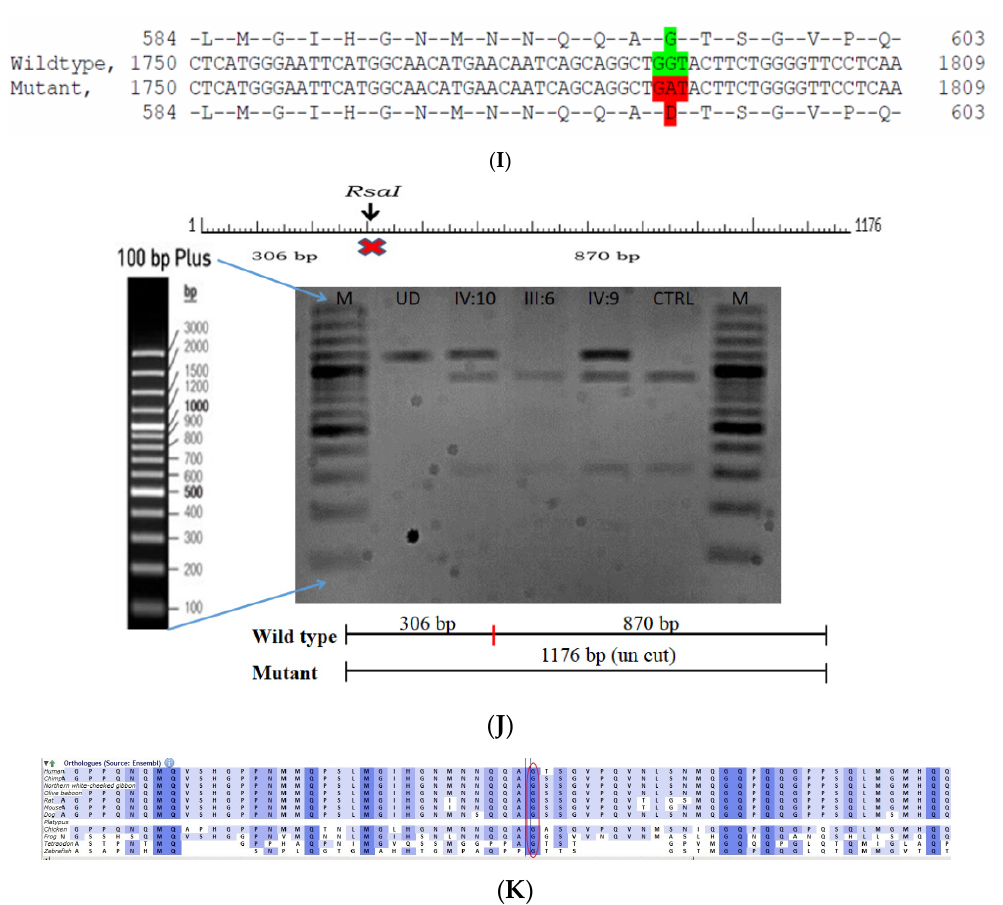
Figure 6. Pedigree of BCC23 ( A ). Clinical phenotype of probands (IV:8): right eye depicting posterior subcapsular cataracts ( B ) upon retro-illumination. Partial sequence chromatogram of BCC23 family members, FYCO1 exon 17, depicting a homozygous mutation (c.4288_4290del; ∆ E1430) in the proband’s brother (IV:10) ( C ), and control subject ( D ) showing a wildtype sequence. Site of mutation was marked by an arrow. The mutation leads to an in-frame deletion of a single amino acid (marked in red) compared with the wildtype sequence (marked in green) ( E ). Amino acid sequence alignment of human FYCO1 and orthologs from other species ( F ), showing a conservation of p.E1430 (encircled in red). Partial sequence chromatograms (reverse) of the proband’s a ff ected brother (( G ), IV:10) and control subject ( H ), NCOA6 exon 9, depicting a homozygous mutation (c.1790G > A; p.Gly597Asp). Mutant and wildtype peaks “T” and “C” marked by an arrow. Missense mutation (marked in red) compared with the wildtype sequence (marked in green) ( I ). RFLP analysis ( J ) of the variant allele p.Gly597Asp in NCOA6 , which shows co-segregation among the a ff ected family members (IV:9 and IV:10). Una ff ected father (III:6) and control (CTRL-DKC190) shows complete digestion, indicating a wildtype sequence. UD—undigested PCR product. Amino acid sequence alignment of human NCOA6 and orthologs from other species, showing a conservation of p.G596 (encircled in red). Divergent amino acid residues are shaded in a white background ( K ).